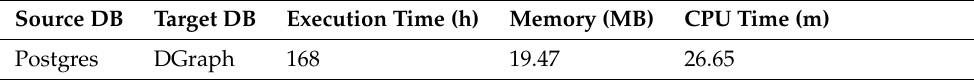
Table 5. Migration process evaluation in the scenario Postgres ⇒ Dgraph. Postgres is the source RDBMS.